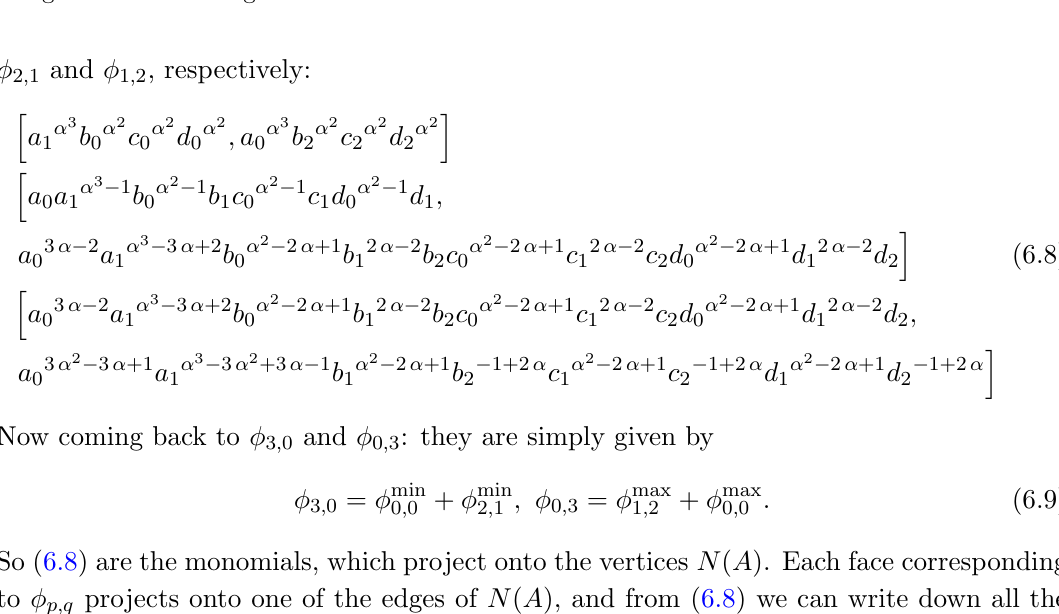
Figure 15 . The mixed decomposition induced by (cid:30) 1 ; 2 : there are three red cells, which correspond to three binomials in (6.3), while the union of blue cells give the monomial (cid:22) 1 ; 2 (6.4). This picture is a generalization of (cid:12)gure 5 to